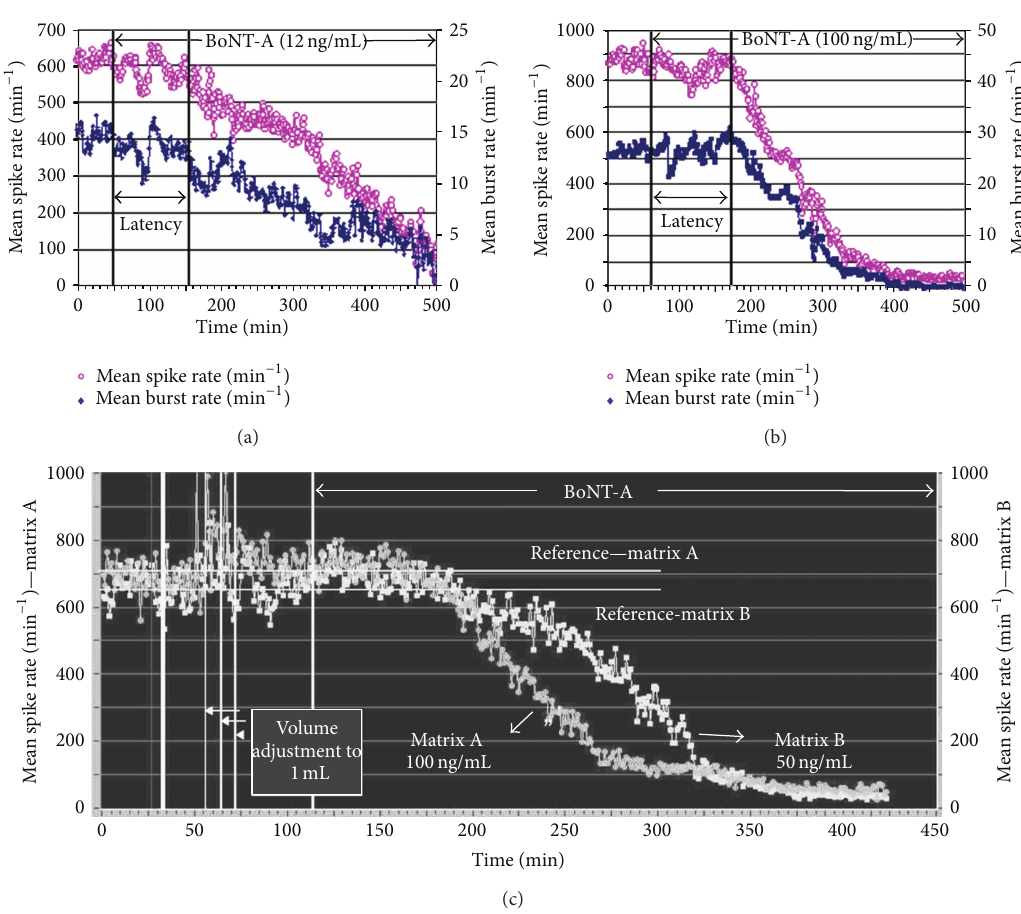
Figure4:CharacteristicresponseprofilesfromtwodifferentCNStissuesandtwodifferentconcentrationsofBoNT-A.(a)Spinalcordnetwork exposed to 12ng/mL showing a latency of 100 min and a 90% decrease in 500 min. (b) Frontal cortex network exposed to 100 ng/mL showing a latency of 110min and a 90% activity decrease in 290 min. (c) Dual networks from age- and maintenance-matched frontal cortex tissue exposed to 50 and 100ng/mL simultaneously. The higher BoNT-A concentration decreased activity more rapidly, reaching 50% inhibition at 110min and 175min for 50 and 100 ng/mL,